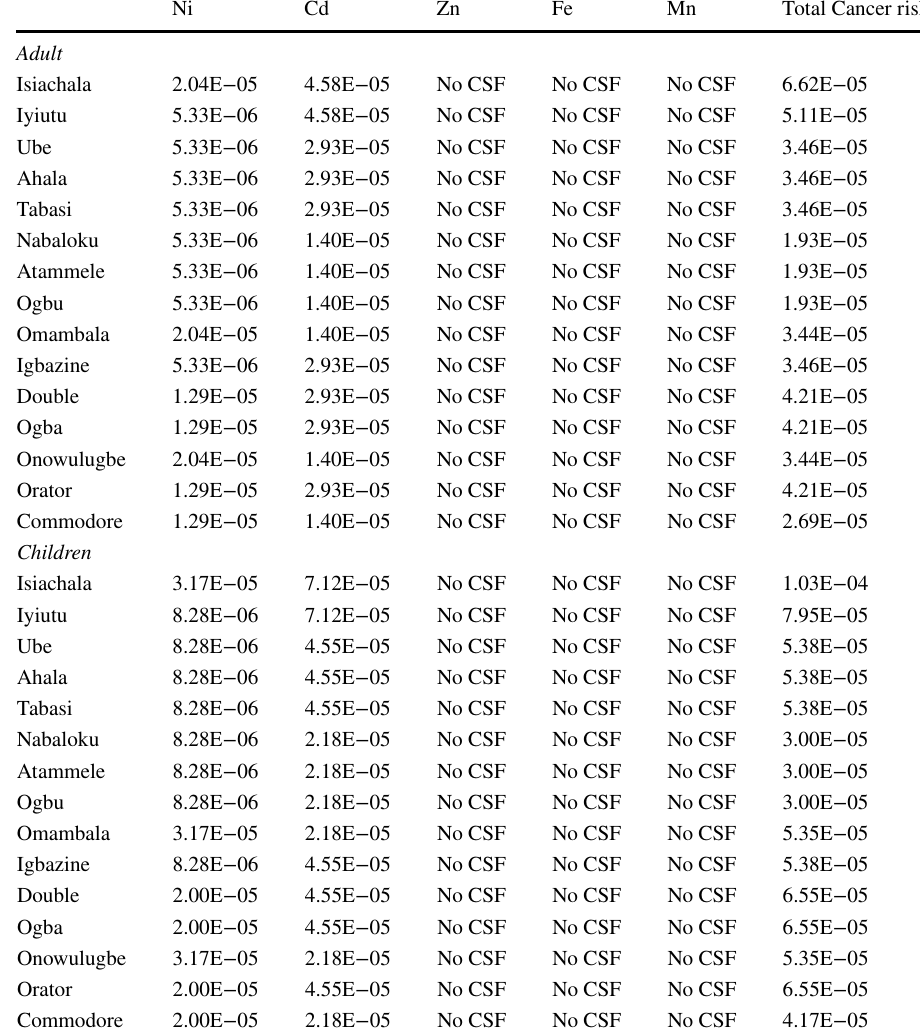
Table 10 Cancer risk evaluation for heavy metals